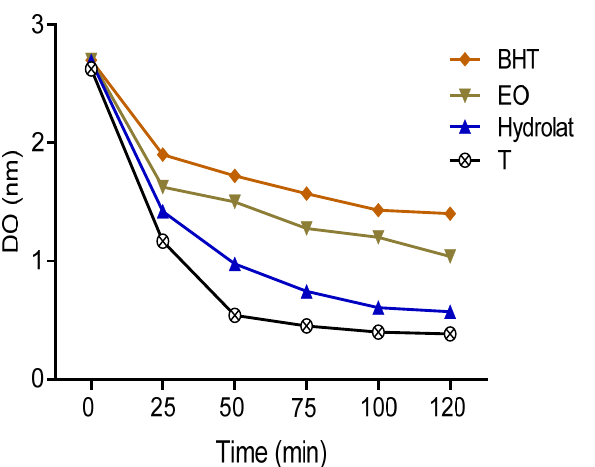
Figure 4. The absorbance of β -carotene in the presence of the samples studied, BHT, and control.